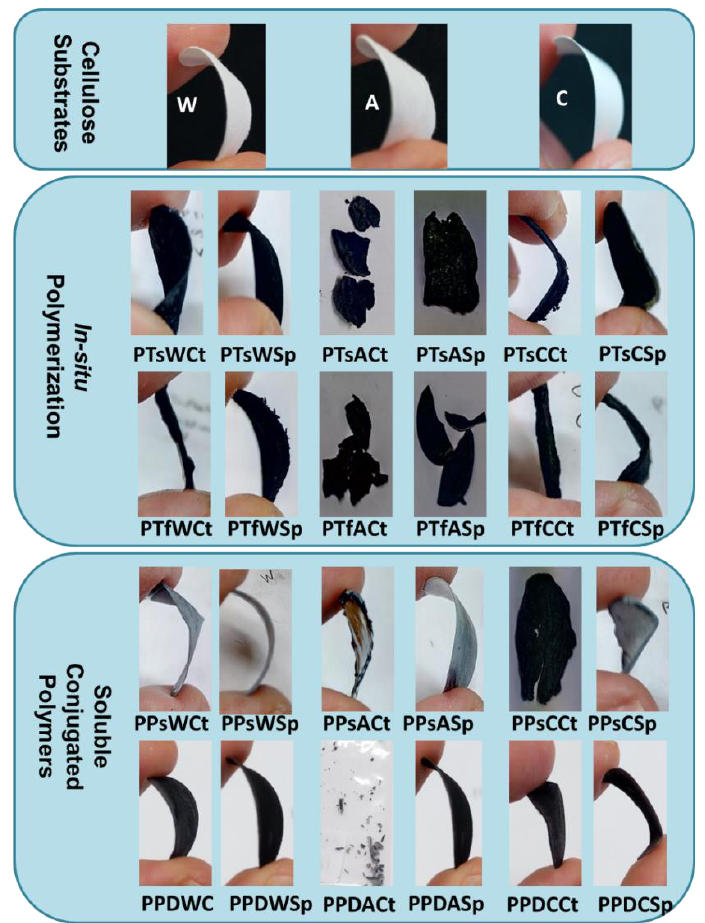
Figure 1. Images of polythiophene-derived composite materials.